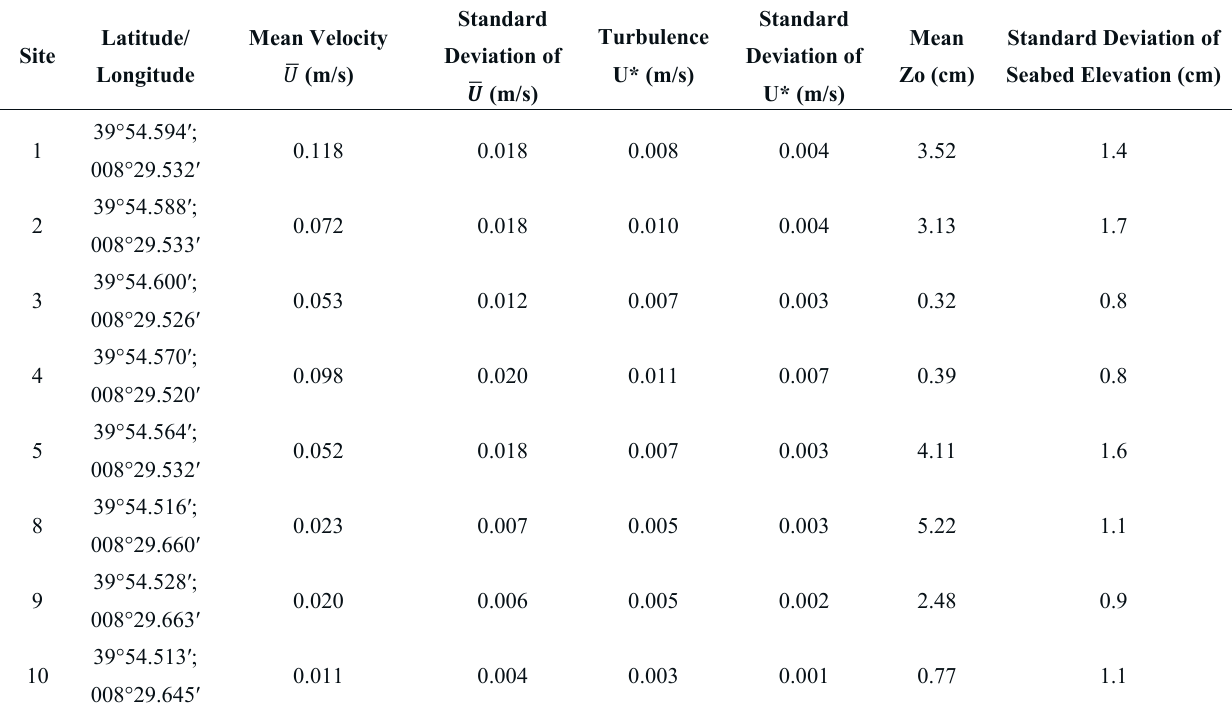
Table 2. Position, mean velocity, turbulence, and topography of the BRAD deployment